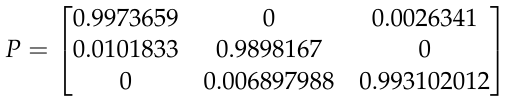
Table 1. The area percentage of three types of land use in Nansha District from 2010 to 2019. Year